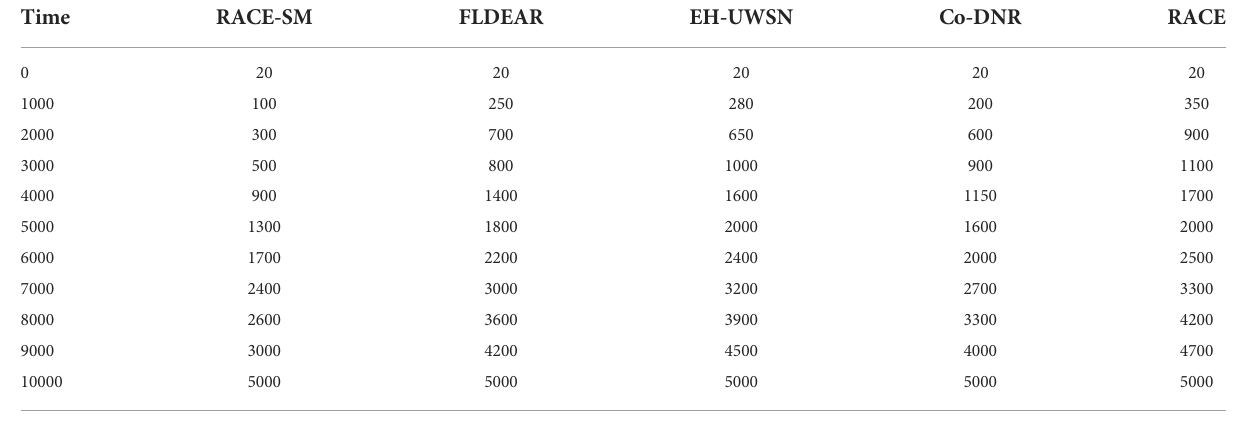
TABLE 2 Protocols addressing energy consumption.